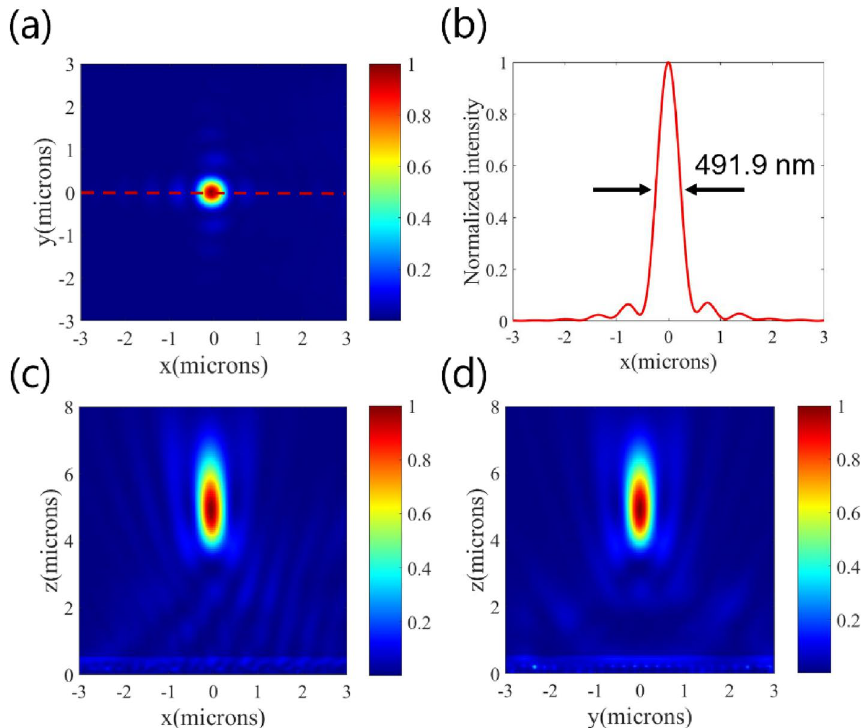
Fig. 8 Simulation results of a designed metalens with NA 0.73 at the illumination wavelength of 633 nm. = The area of this metalens is 7.5 7.5 μm 2 (30 30 units), and the focal length is 5 μm. ( a ) Normalized intensity × × profile of the metalens at the focal plane (z 5 μm). ( b ) Corresponding normalized intensity profile along the = red dashed line in ( a ). Normalized intensity distribution in the x‑z plane ( c ) and y‑z plane ( d ). The metalens